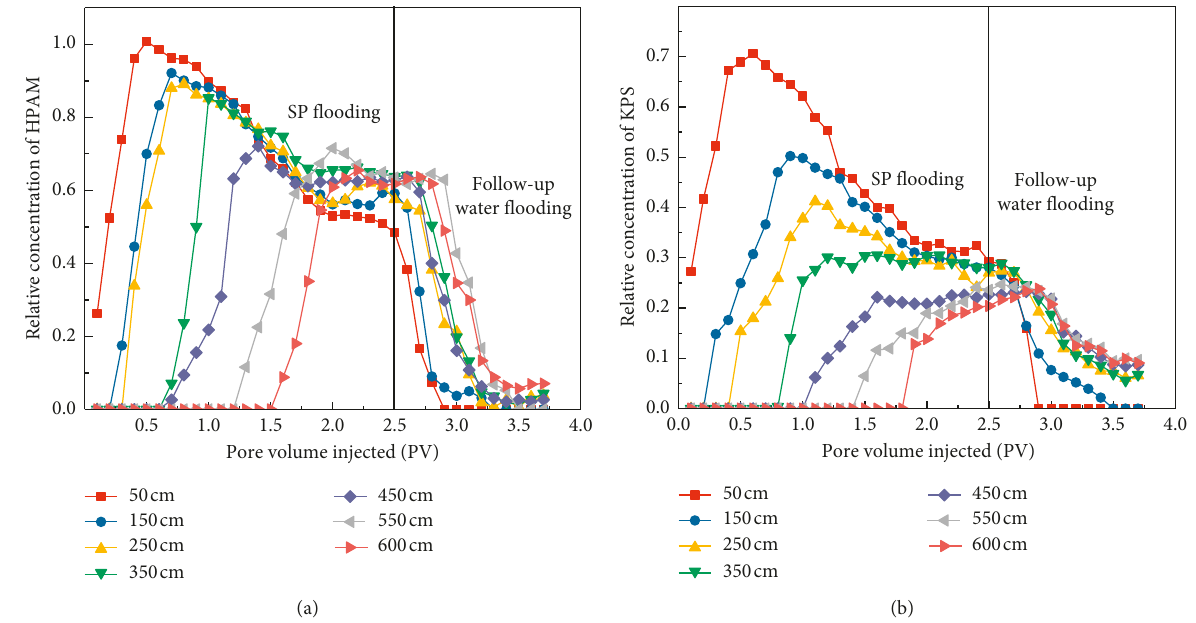
Figure 4: Variation of the relative concentration of polymer and surfactant at each sampling point: (a) relative concentration of HPAM; (b) relative concentration of